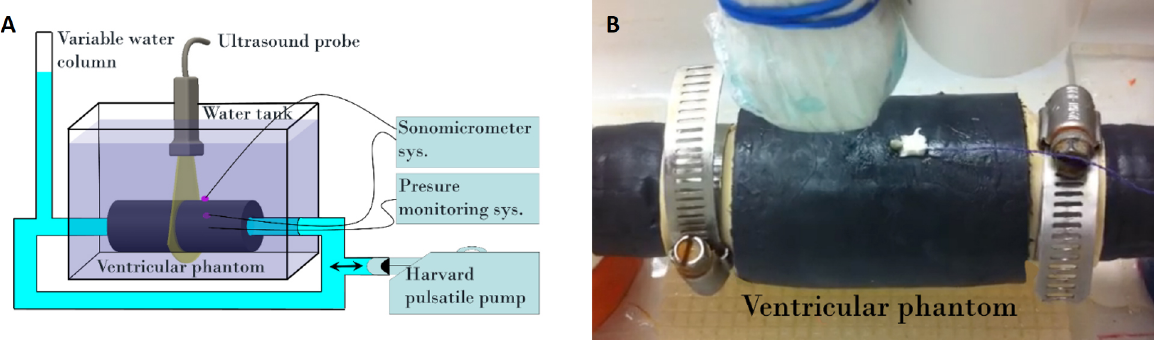
Fig 1. (A) Illustration of the experimental setup and (B) photo zoomed on the phantom model.